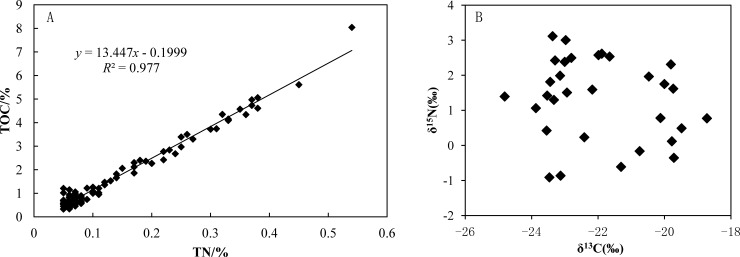
(A) TOC concentration compared to TN concentration; (B) δ15N compared toδ13C.